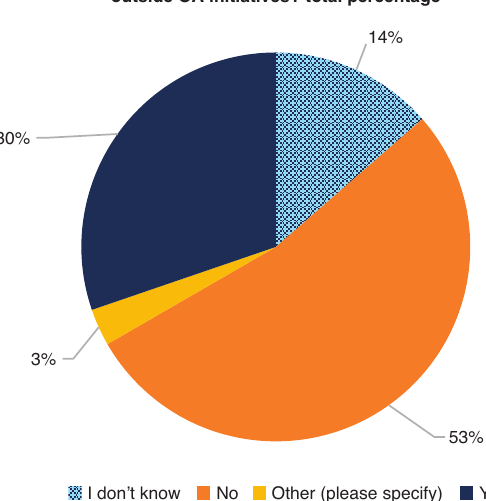
Chart 5: Does your library financially support outside OA initiatives – Total